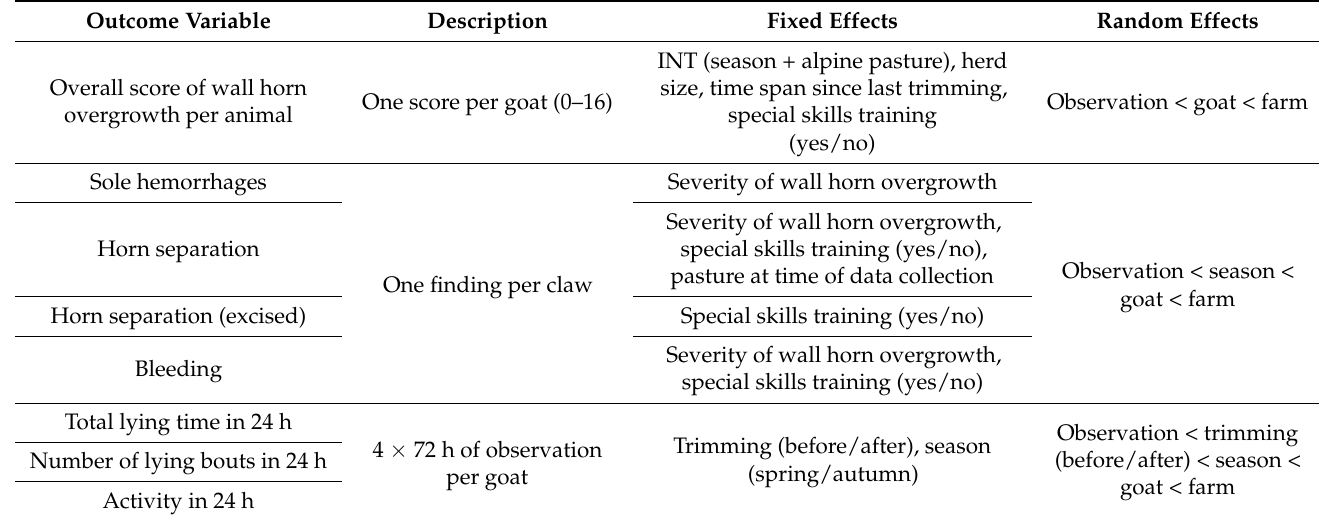
Table 3. Fixed effects (explanatory